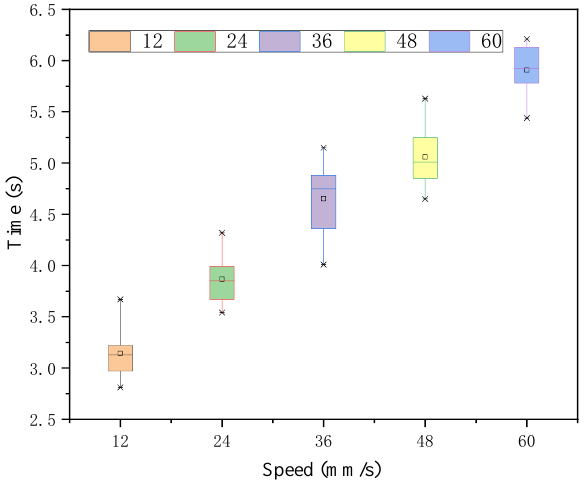
Figure 10. Response time of each speed target under intensity 32 stimulation. Table 4. Time statistic value under intensity 32.